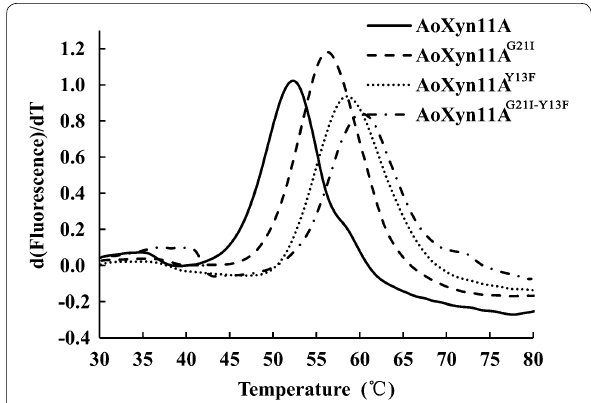
Fig. 6 The derivative melting curves of four recombinant xylanases. Emission intensities of fluorescence dye combining with protein hydrophobic regions were recorded from 30 to 80 °C at an elevated rate of 1 °C min −